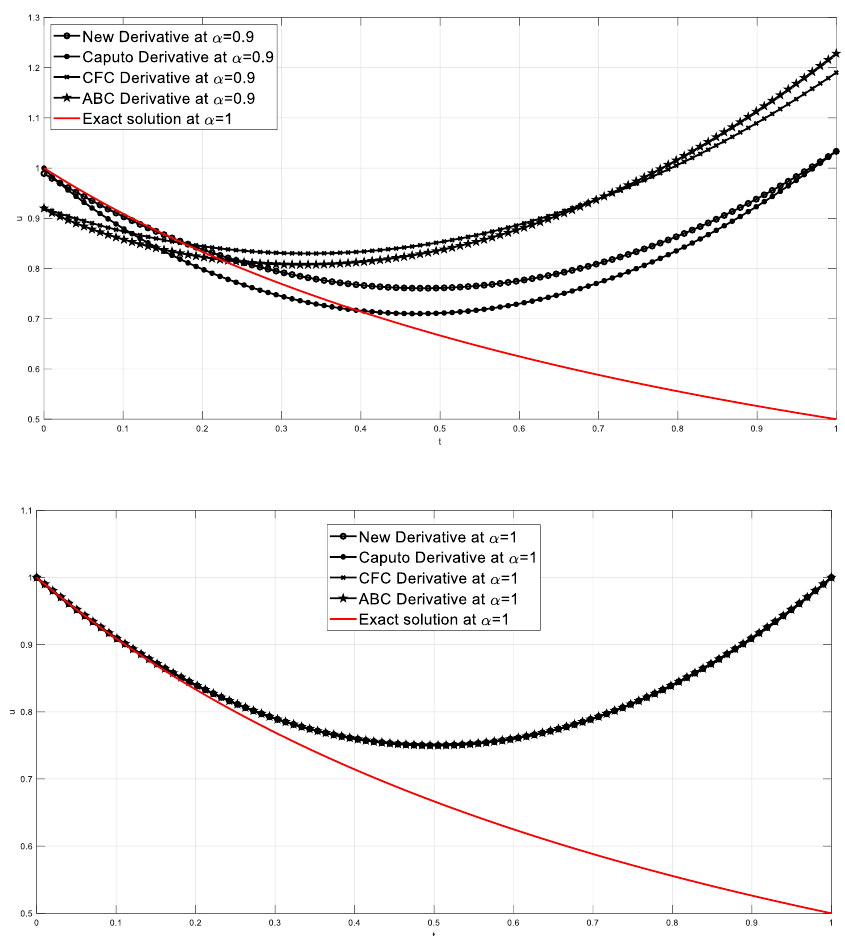
Mathematics 2022 , 10 , x FOR PEER REVIEW